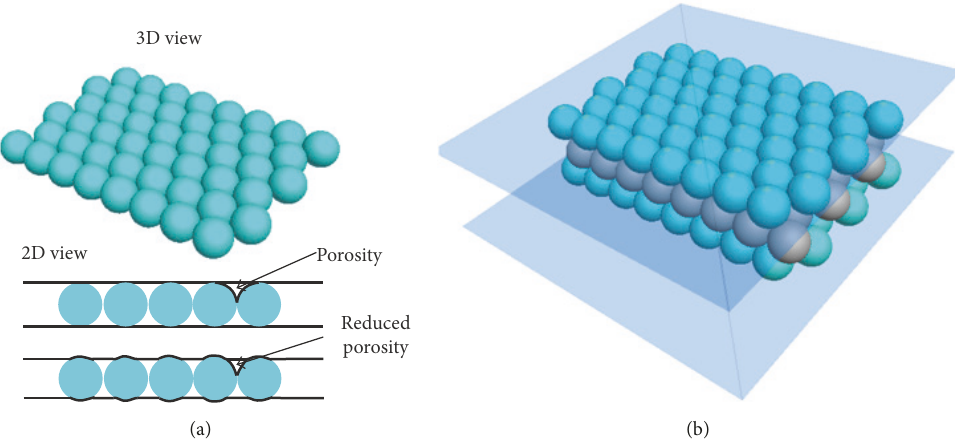
Figure 10: Idealized close-packing of monosized particles as (a) a monolayer and (b) multiple layers (FCC